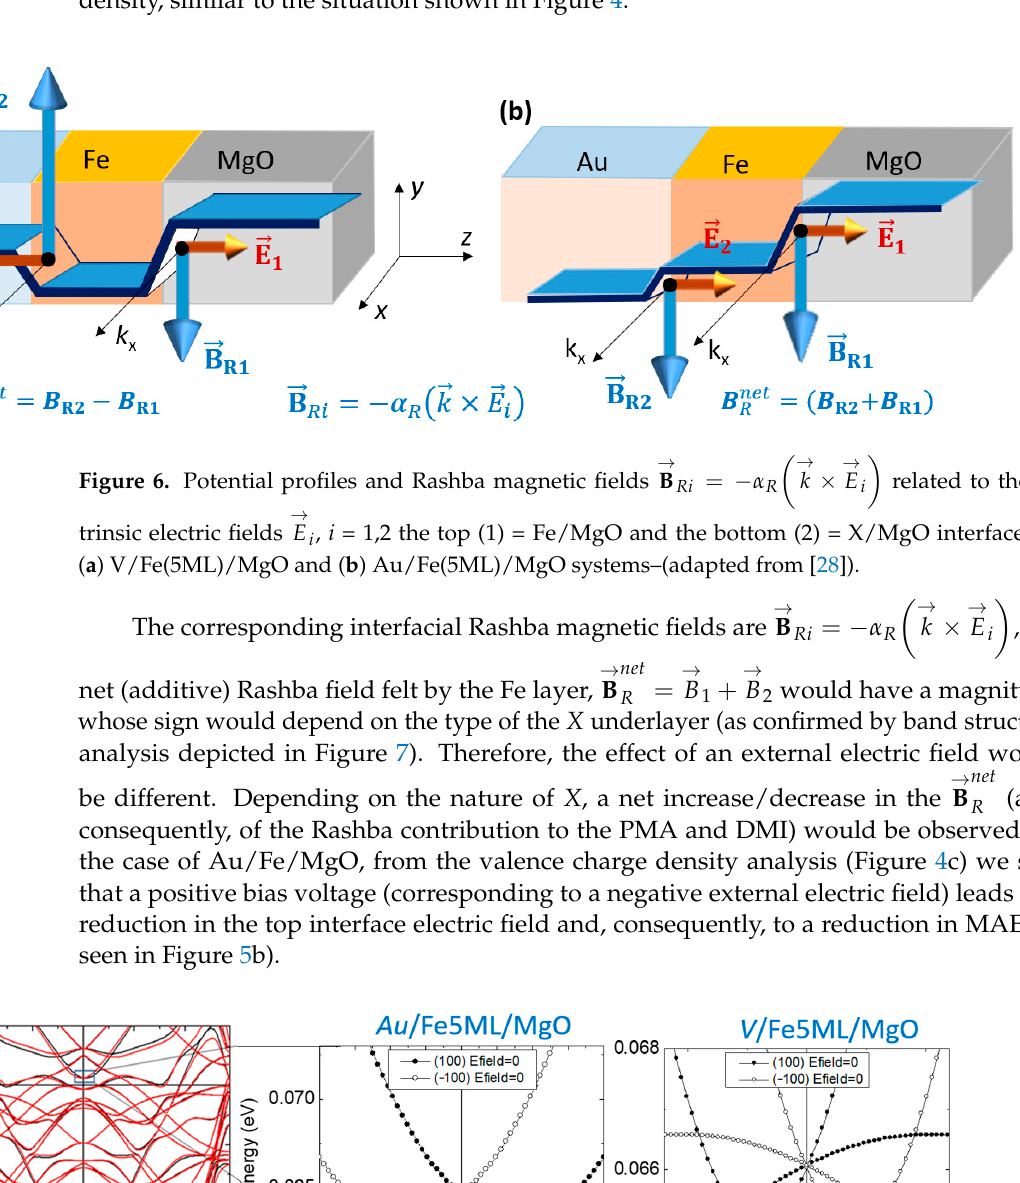
Figure 5. Opposite sign variation of the perpendicular magnetic anisotropy energy ( K u ) with an applied electric field (E-field) calculated for ( a ) V/Fe(5ML)/MgO and ( b ) Au/Fe(5ML)/MgO super- cells- (adapted from [28]).